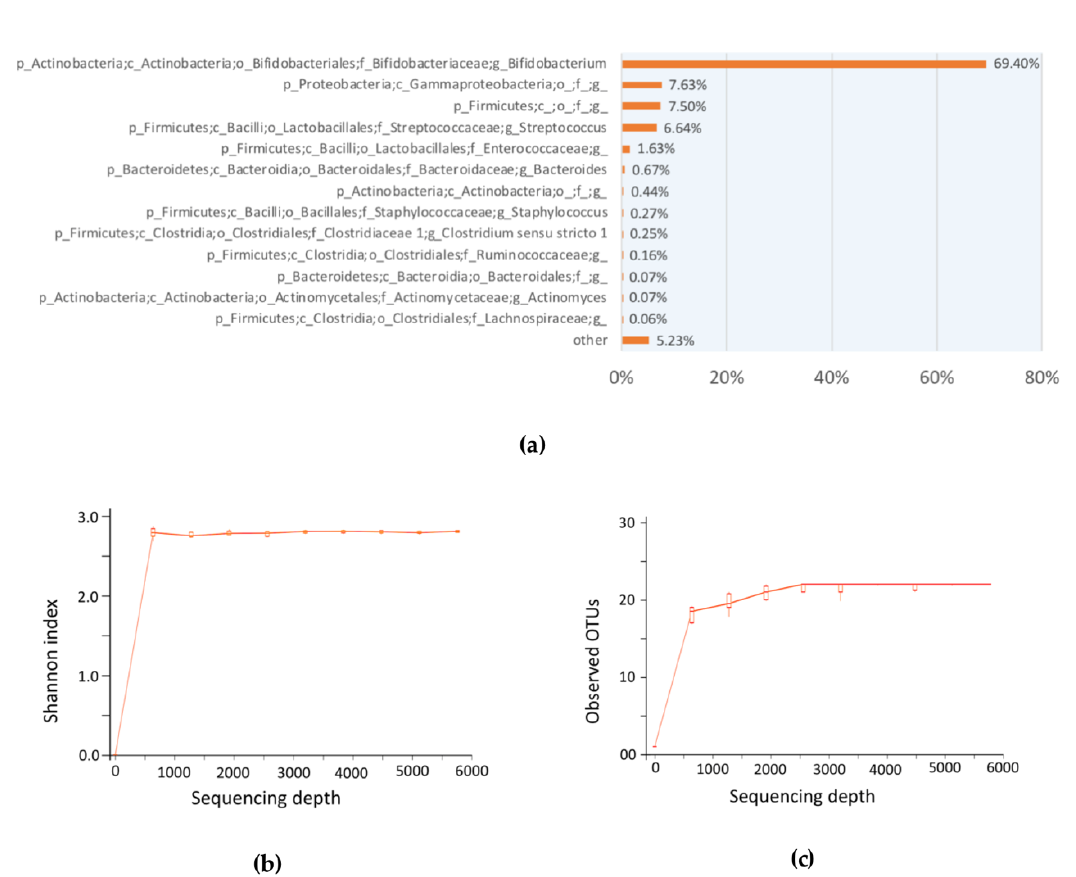
Figure 3. Qiime2 analysis result of 16S amplicon sequencing from infant fecal sample before In vitro fermentation investigation. ( a ) The relative bacteria abundance after 16S amplicon sequencing of infant fecal samples before fermentation. Only the genera level is extracted and shown. Most of the bacteria present in the infant fecal samples were Bifidobacterium sp. and, therefore, commensal bifidobacteria are enumerated as total probiotics; ( b ) alpha diversity analysis of Shannon index; ( c ) alpha diversity analysis of observed OTUs (operational taxonomic